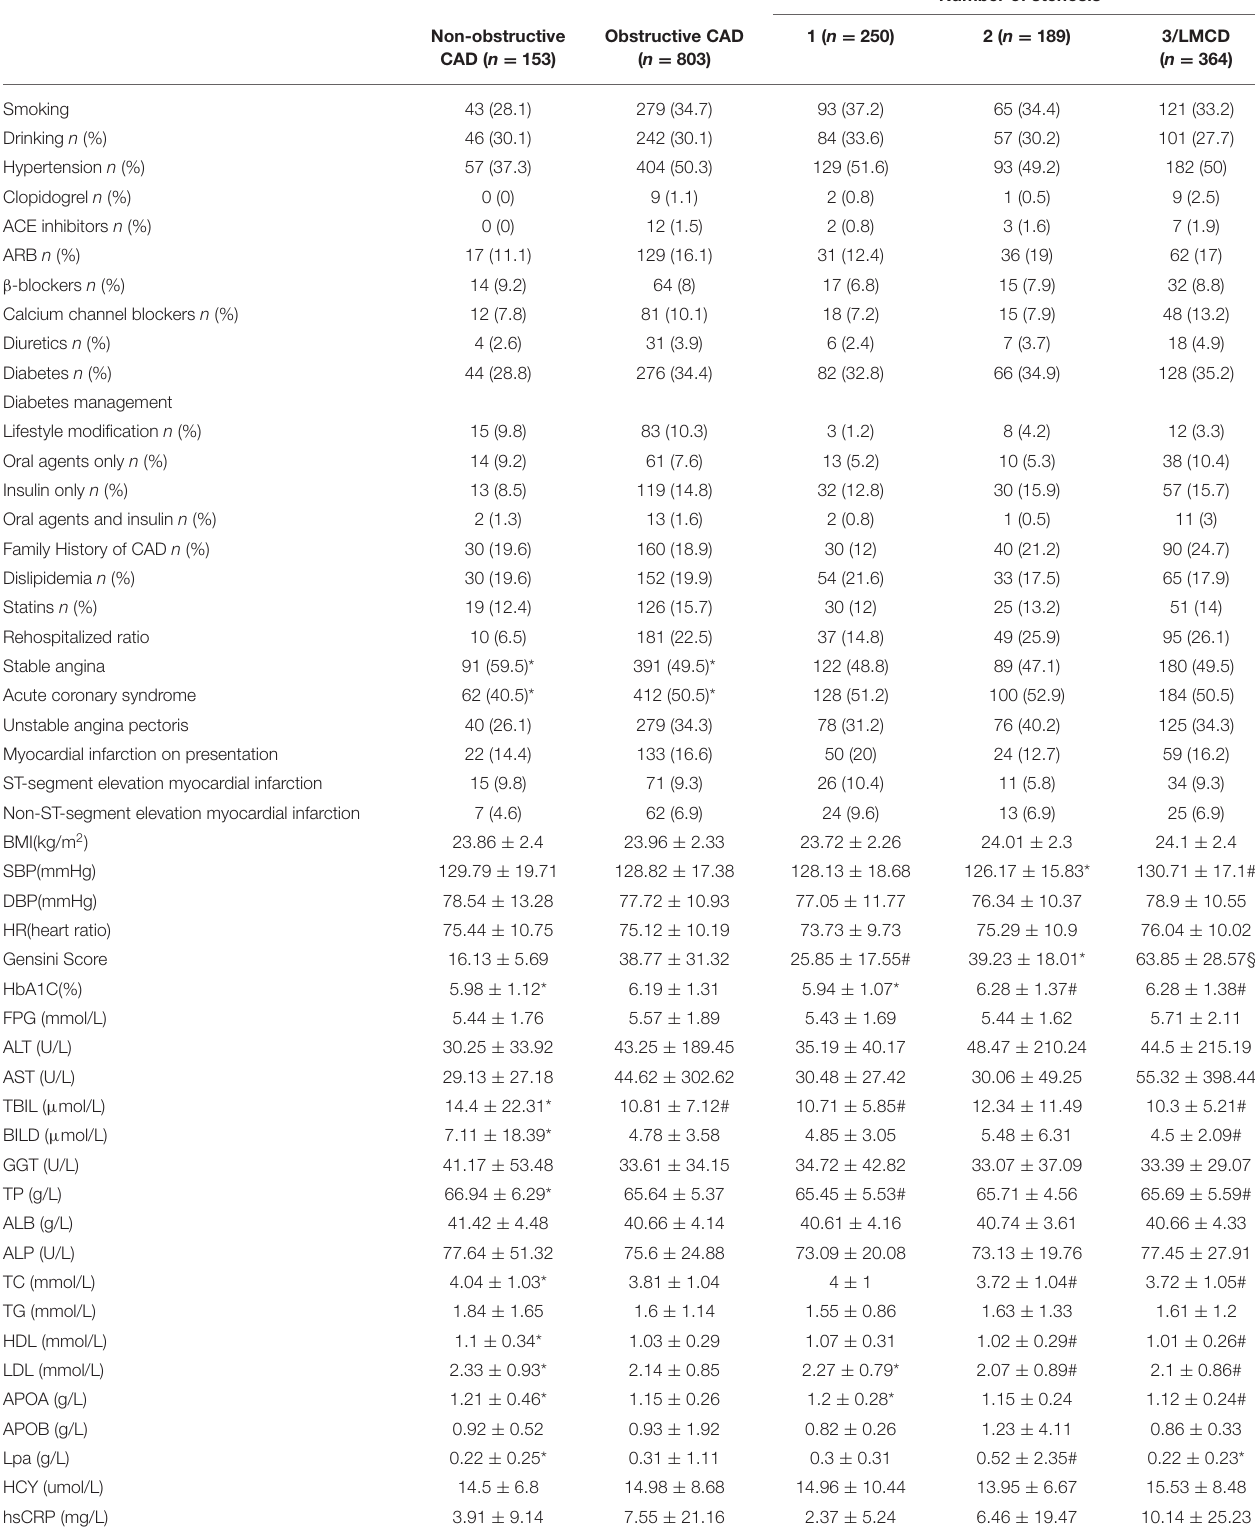
TABLE 1 | Clinical characteristics of